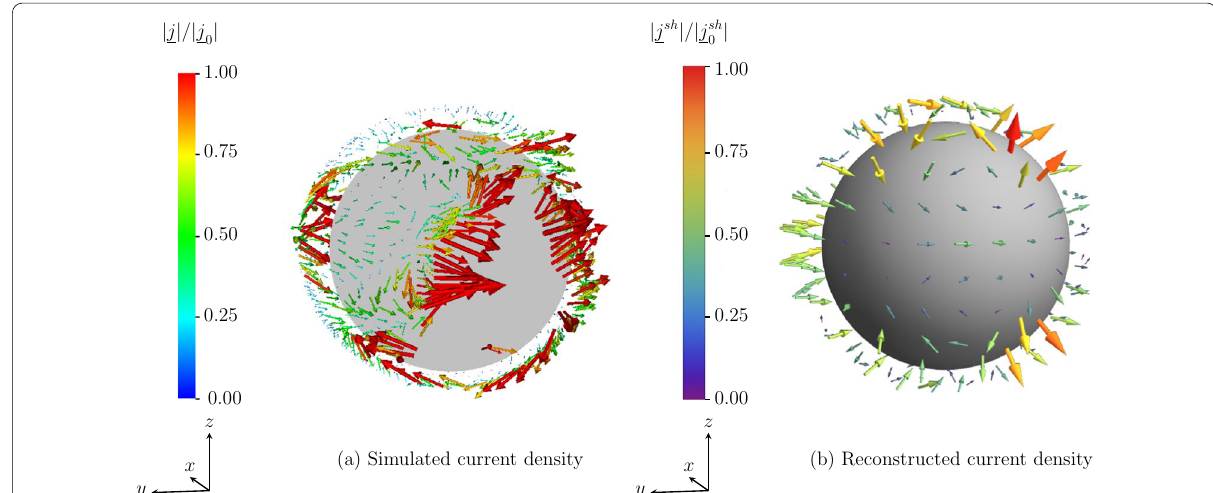
= 25nA / m 2 along the j sh 0 (cid:31) (cid:31) (cid:31) (cid:31)